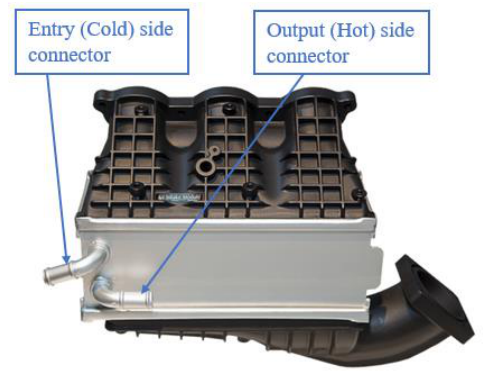
Fig. 1. Water charge air